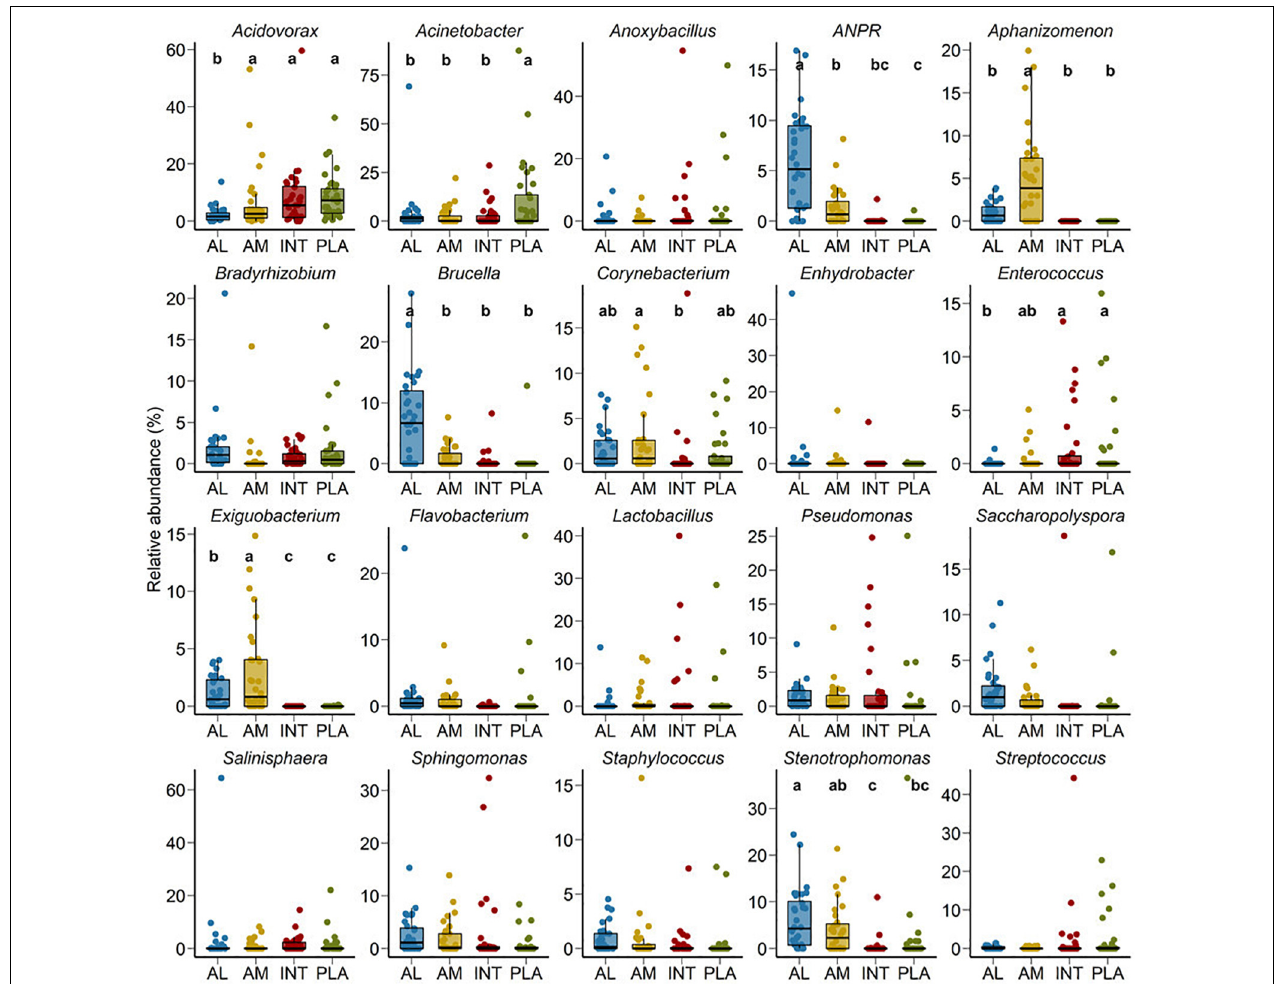
FIGURE 2 | Percent relative abundance of the 20 most relatively abundant bacterial genera in the allantoic (AL) and amniotic (AM) fluid, and intestinal (INT) and placental (PLA) tissue microbiota in 83-day-old calf fetuses. The different lowercase letters indicate significantly different means ( P < 0.05).